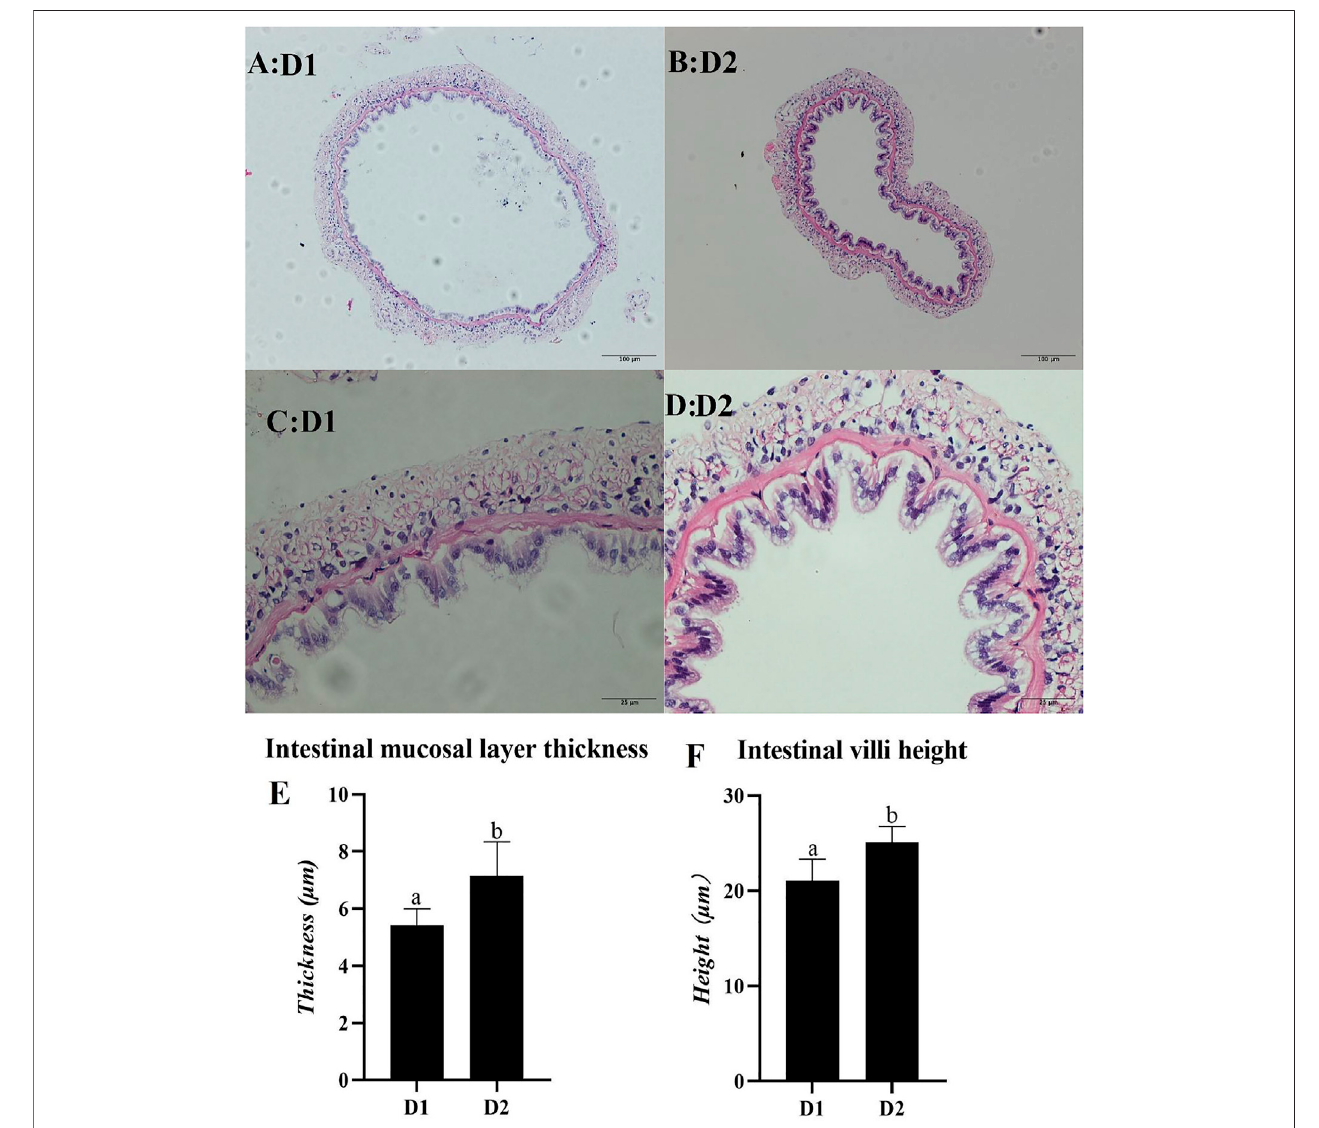
FIGURE 5 | Light microscopy of mid-intestine morphology of L. vannamei fed diet supplemented with/without H. pluvialis GXU-A23 for 56 days. The scale bars of picture (A,B) were100 μ m,whilethescalebarsofpicture (C,D) were25 μ mrespectively.Picture (E,F) representstheintestinalmucosallayerthicknessandintestinalvilli height of L. vannamei respectively. Values are mean ± SE ( n = 4). The small letters indicated signi fi cant differences at p < 0.05.